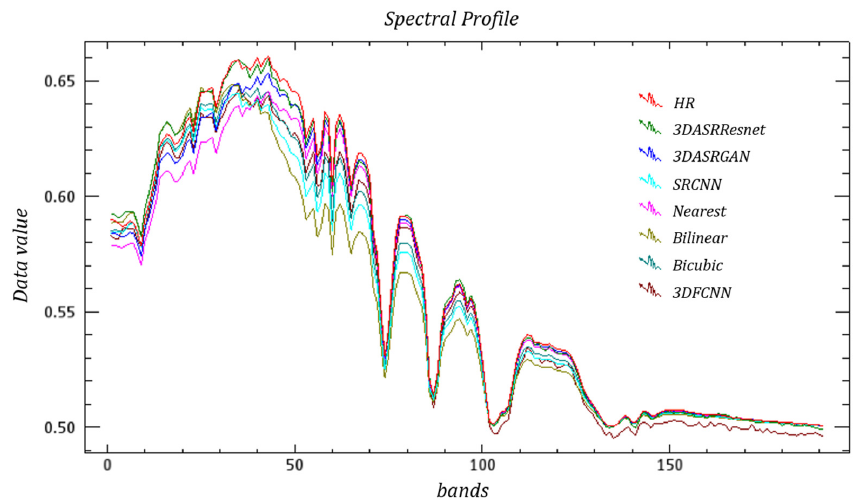
Figure 10. Example Spectral Curves of Roof based on Washington DC Mall dataset.